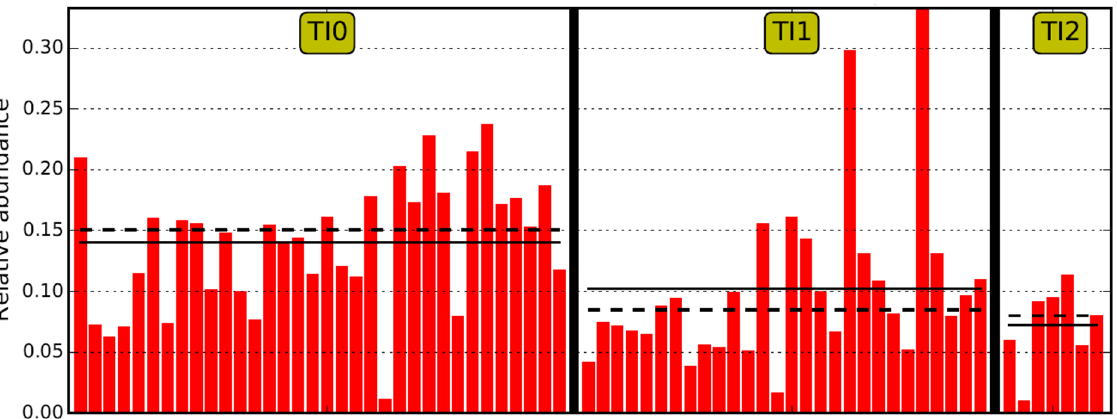
Figure 3. Comparison of the mean (dashed horizontal line) and median (solid horizontal line) abundance of Lachnospiraceae in TI in controls (TI0), active CD (TI1) and inactive CD (TI2).